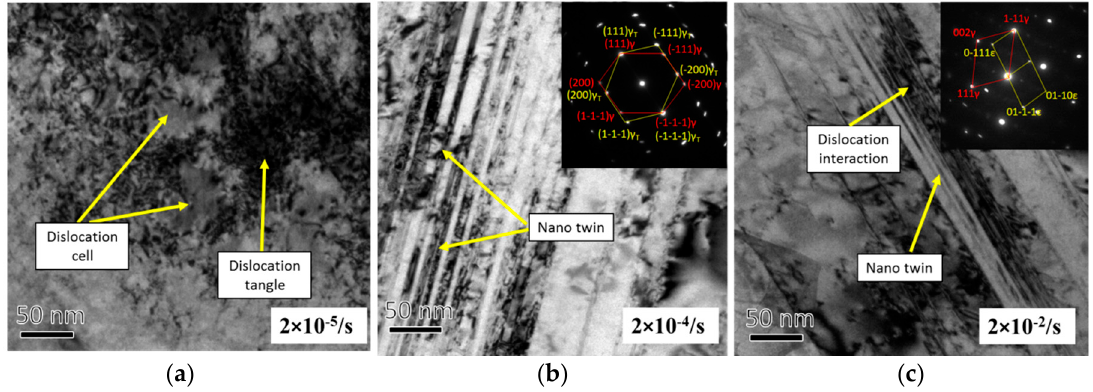
Figure 4. Presence of dislocation cell, dislocation tangles, nanotwins in deformed austenite at: ( a ) 2 × 10 − 5 /s, ( b ) 2 × 10 − 4 /s and ( c ) 2 × 10 − 2 /s strain rates. The SAED pattern of the nanotwins is showing orientation relationship with the parent RA grains.